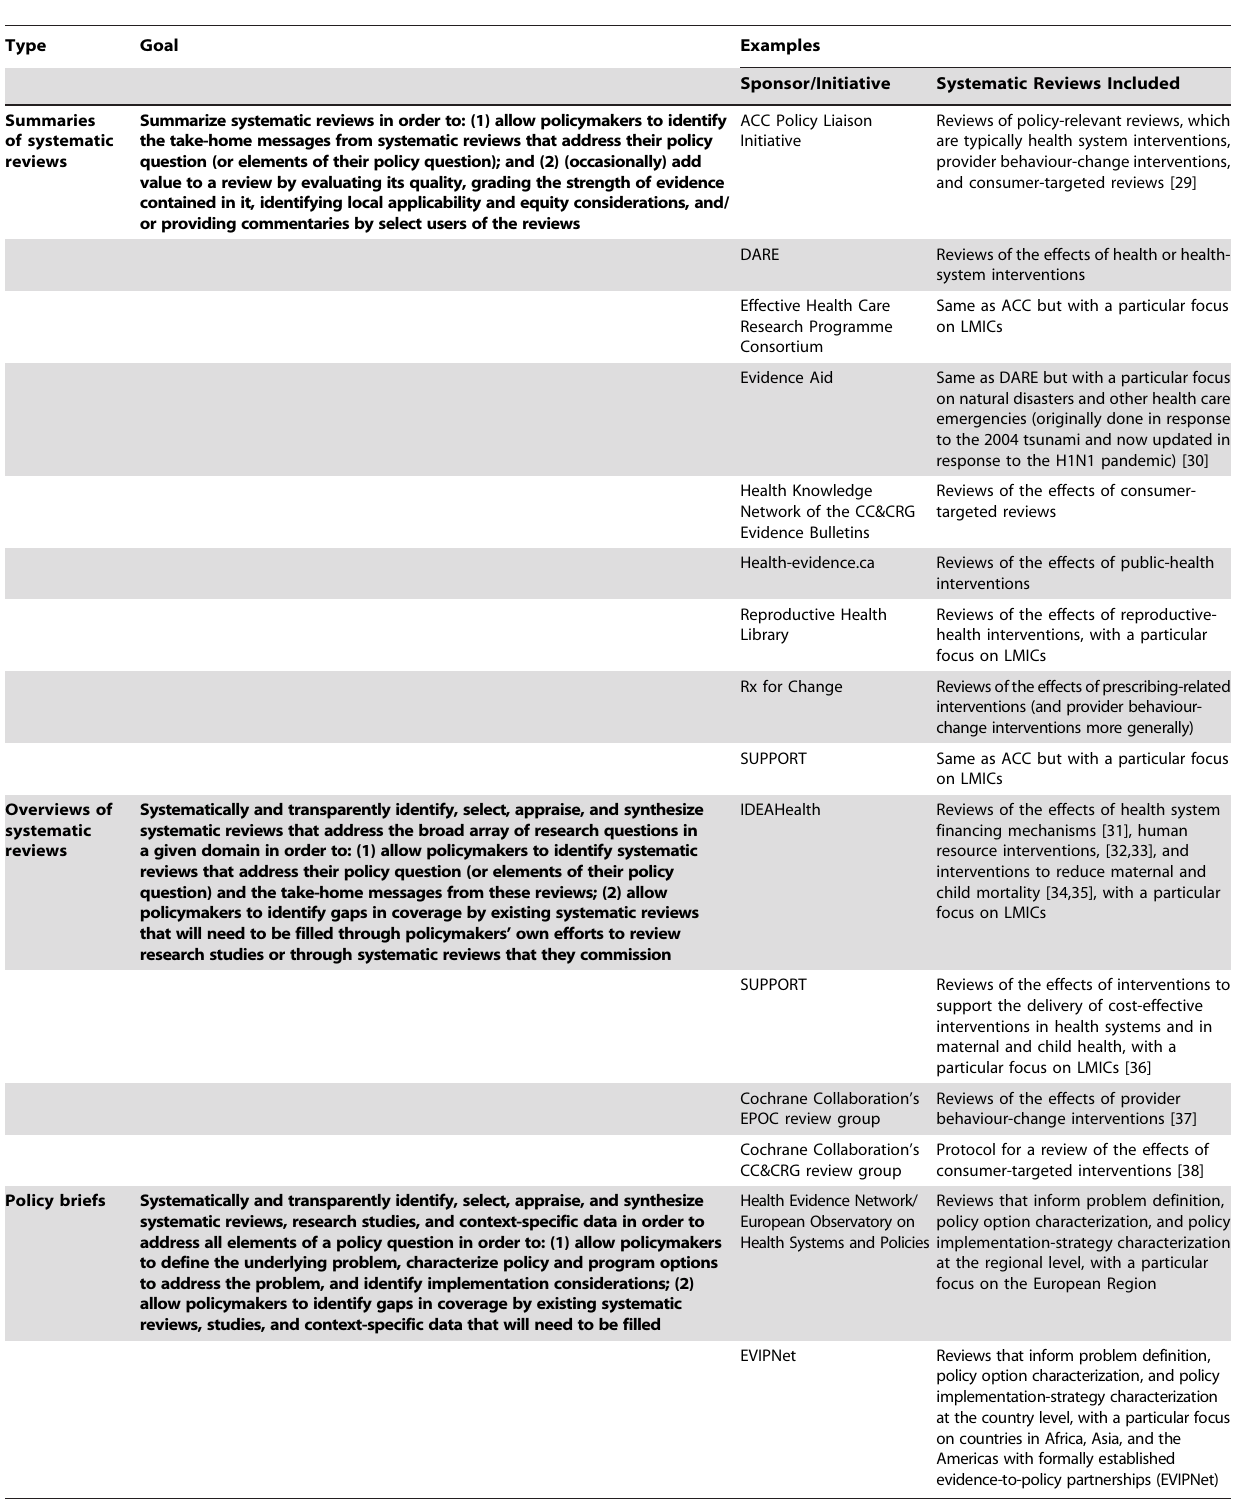
Table 2. Examples of review-derived products targeted at policymakers and